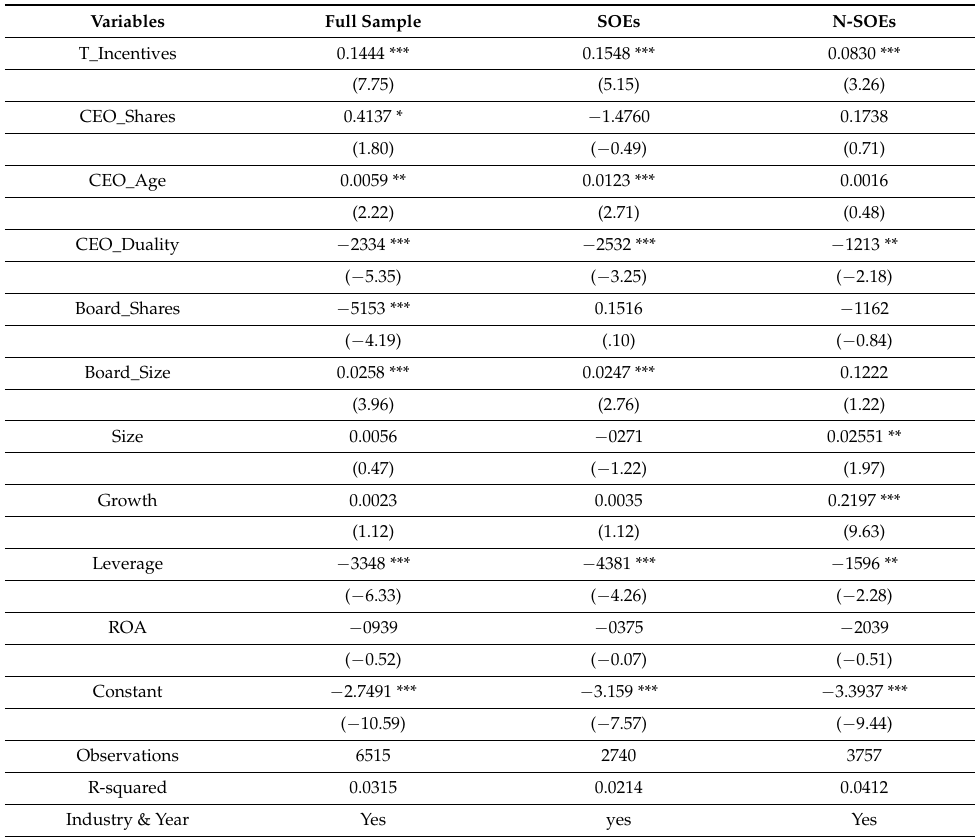
Table 6. Propensity score matching (PSM) results.